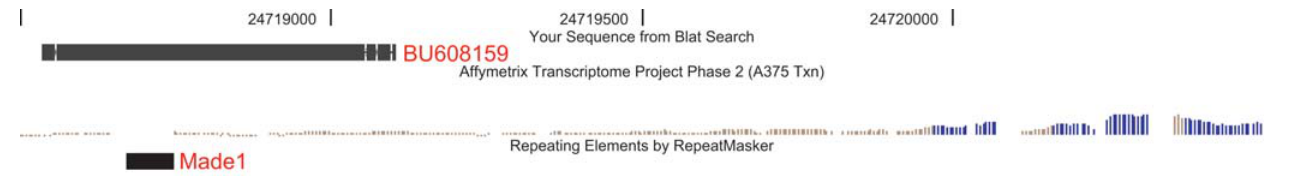
Figure 3. Made1 insertion in a transcriptionally active region of the human genome. The Made1 element shown is expressed by read-through from an adjacent promoter position in the genome. The EST BU608159 consists of the Made1 element along with 678 bp of flanking DNA.